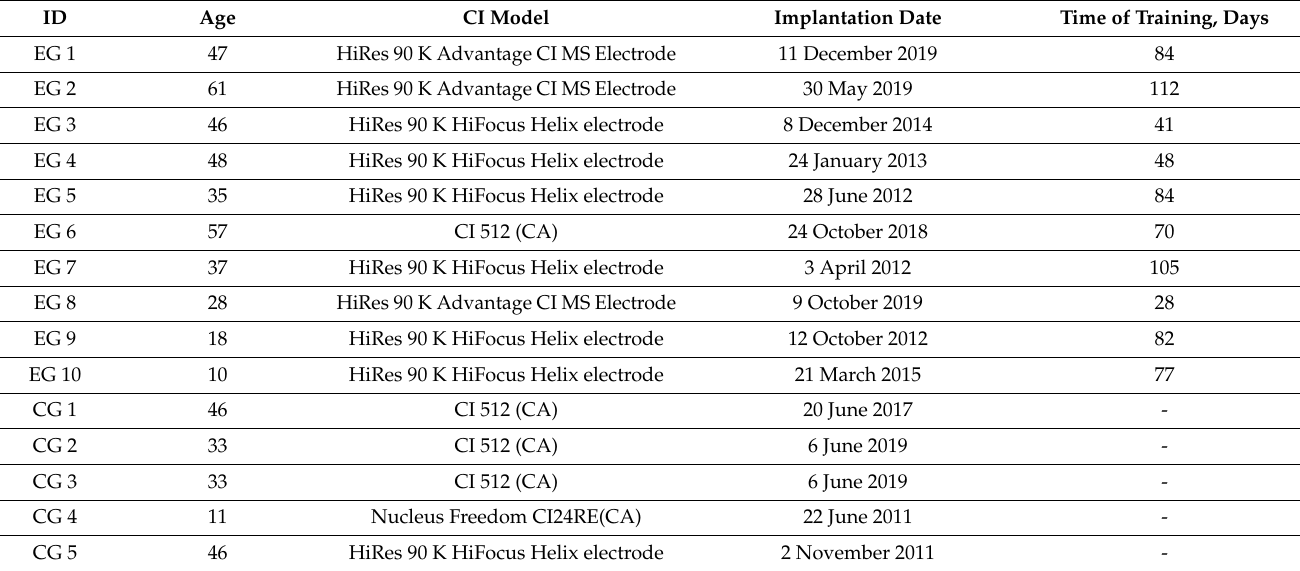
Table 1. Basic data for the CI